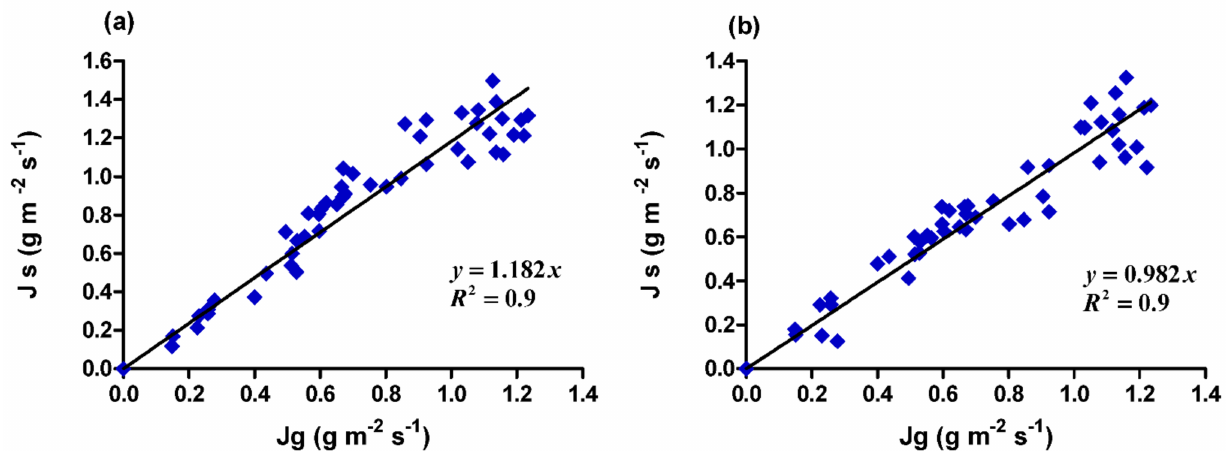
Figure 4. Plot of sap flow densities estimated from gravimetric measurements (J g ) versus thermal dissipation probes (J s ), by applying both: values defined by the calibration equation ( a ) and derived by the new parameters ( b